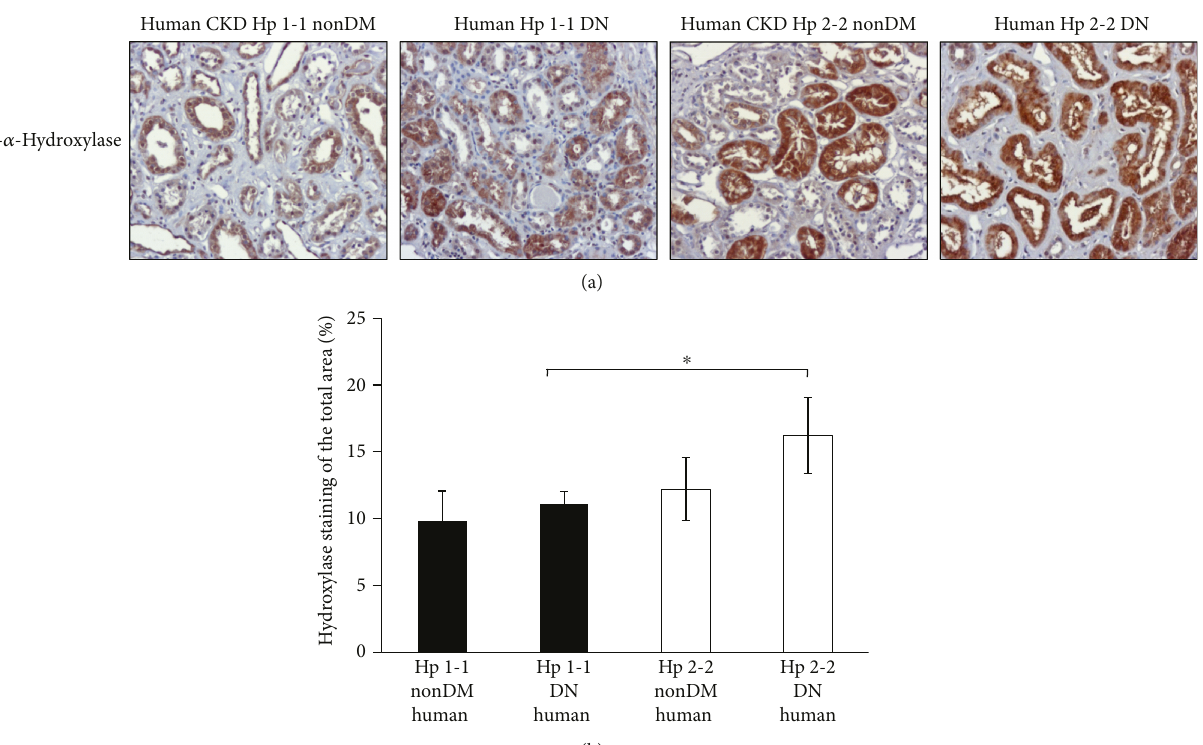
Figure 8: 1- α -Hydroxylase expression in diabetic and nondiabetic (nonDM) CKD patients. (a) Slides from human ’ s renal biopsies were subjected to IHC of 1- α -hydroxylase. (b) There was a signi fi cant increase in the percentage of the stained area of 1- α -hydroxylase in the tubules of Hp 2-2 DM renal sections compared with Hp 1-1 DM sections ( ∗ p < 0 05 ) but insigni fi cant compared with the nonDM Hp 2-2 genotype.